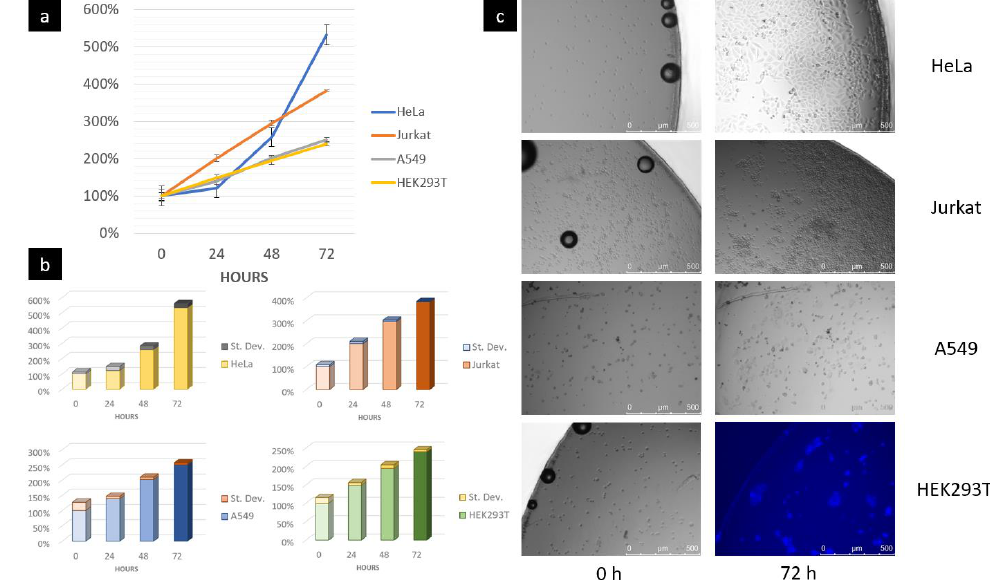
Figure 5. ( a , b ) Average percentage increase relative to 0 h and standard deviation evaluated on three different regions of interest for every cell line during the culture experiment in 72 hours, considering an initial percentage of 100% at 0 h. Additional information about the positions of the regions of interest can be found in Figure S7 in Supplementary Materials Trends are comparable with results present in the literature [57-60]; ( c ) Growth of the cells in a specific region of interest. The presence of bubbles at time 0 h is because the photos have been acquired several minutes after cell seeding. For the HEK293T cell line, a DAPI staining was used. In fact, this cell line has a monolayer shape that makes the cell count more difficult without a fluorescent stain. For the images acquired at time instants 24 h and 48 h, see Figure S8 in Supplementary Materials.